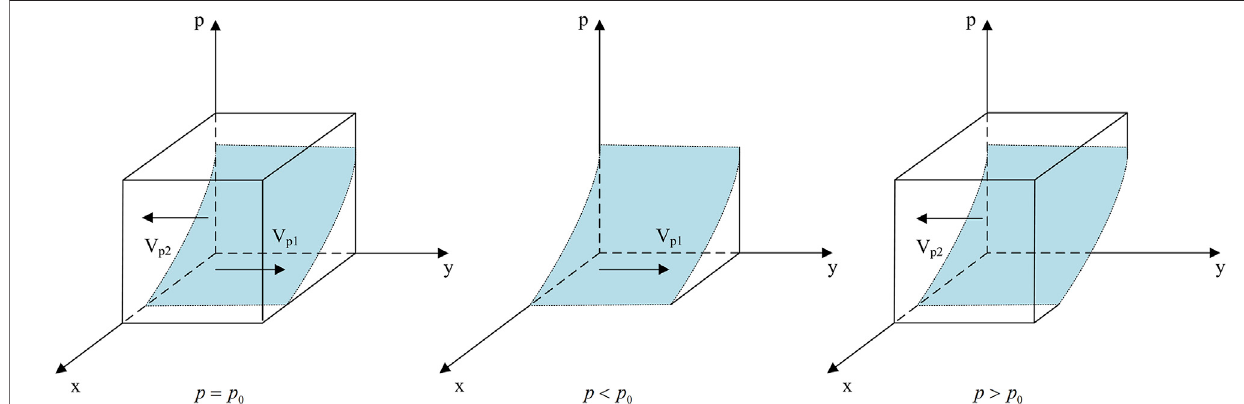
FIGURE 3 | The strategic choices of third-party e-commerce